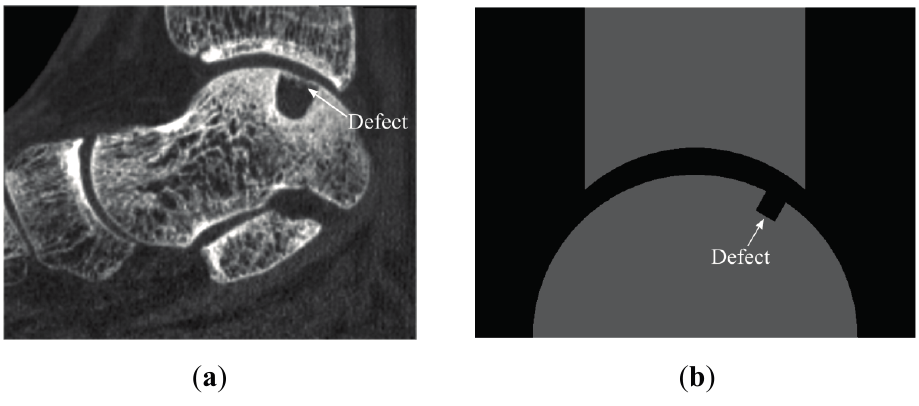
Figure 3. ( a ) Sagittal reconstructed image of CT scans of an ankle with OCD; ( b ) Representation of a defect in simulations.